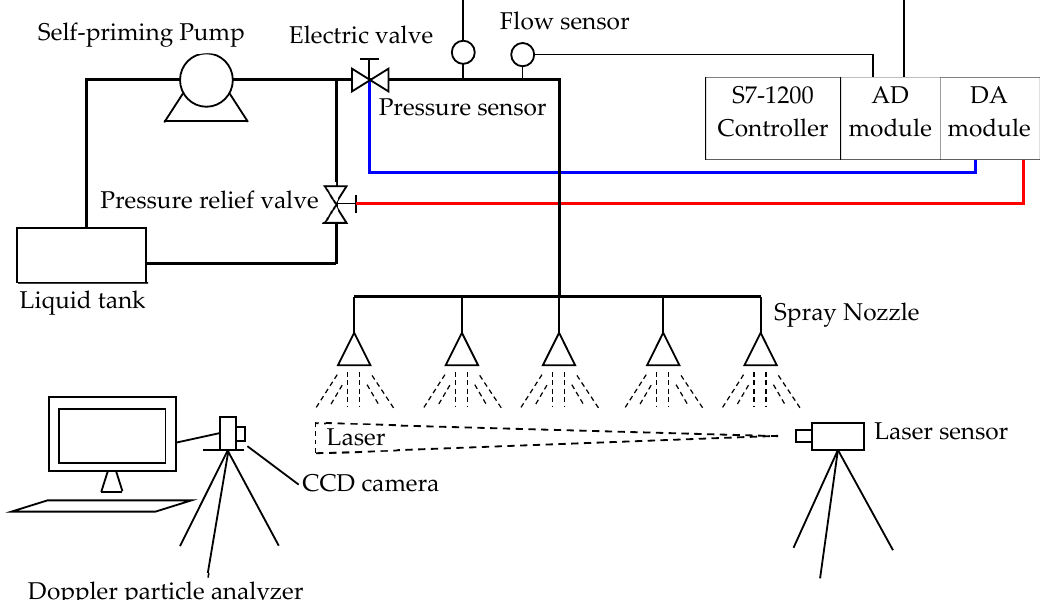
Figure 8. A schematic diagram of the spray test bench.